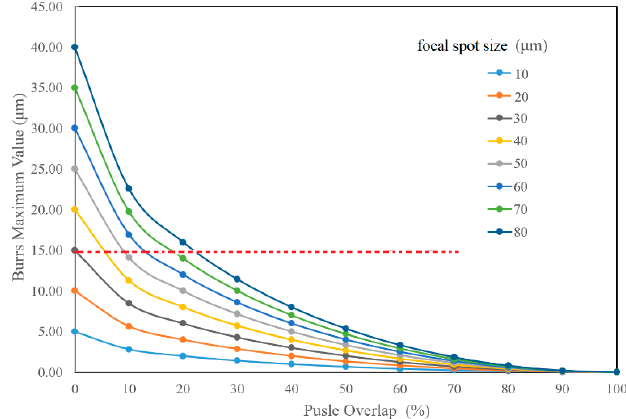
Figure 9. The relationship of the etching border burrs variation with the pulse overlap for different spot sizes. Under the current condition, an accuracy tolerance of 15 µ m is required, which is shown with a red dashed line.